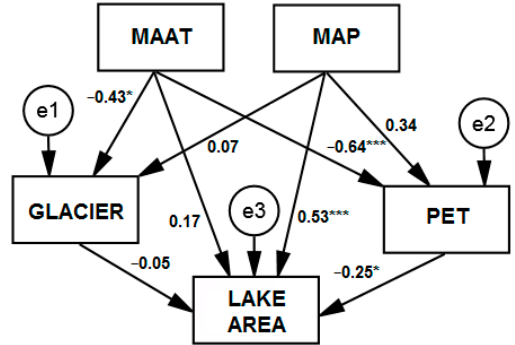
Figure 9. Path diagram results of the structural equation model (SEM). Note: * represents p < 0.1, ** represents p < 0.05, *** represents p < 0.01.